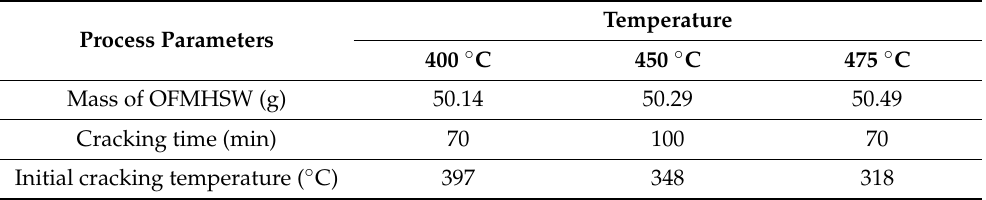
Table 9. Process parameters, mass balances, and yields of reaction products (liquids, solids, H 2 O, and gas) by pyrolysis of MHSW fraction (organic matter + paper) at 400, 450, and 475 ◦ C, 1.0 atmosphere, in laboratory